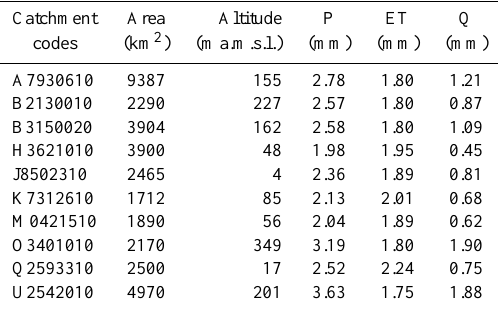
Table 1. Main characteristics of the studied basins (mean annual values) based on a 36 year length of the series (1970–2006). Catchment